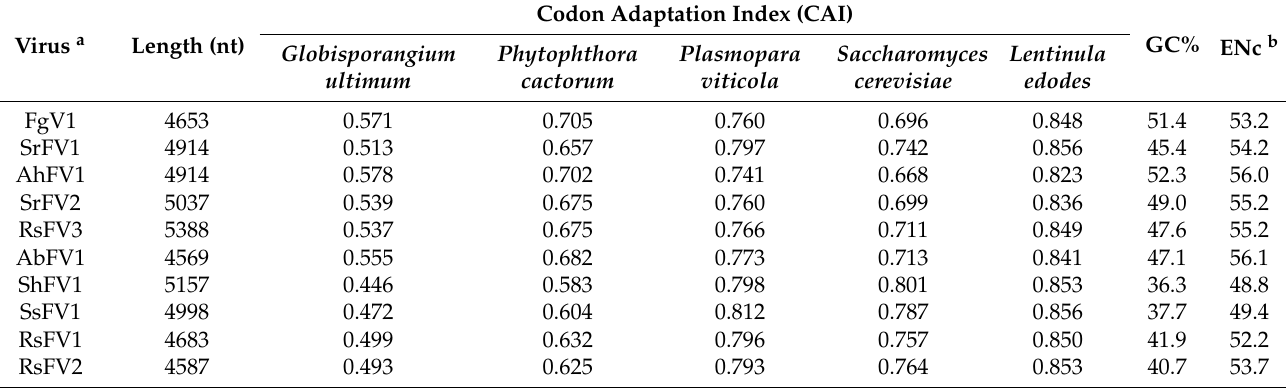
Table 4. Relative Codon Deoptimization Index (RCDI) of RdRp of fusariviruses.